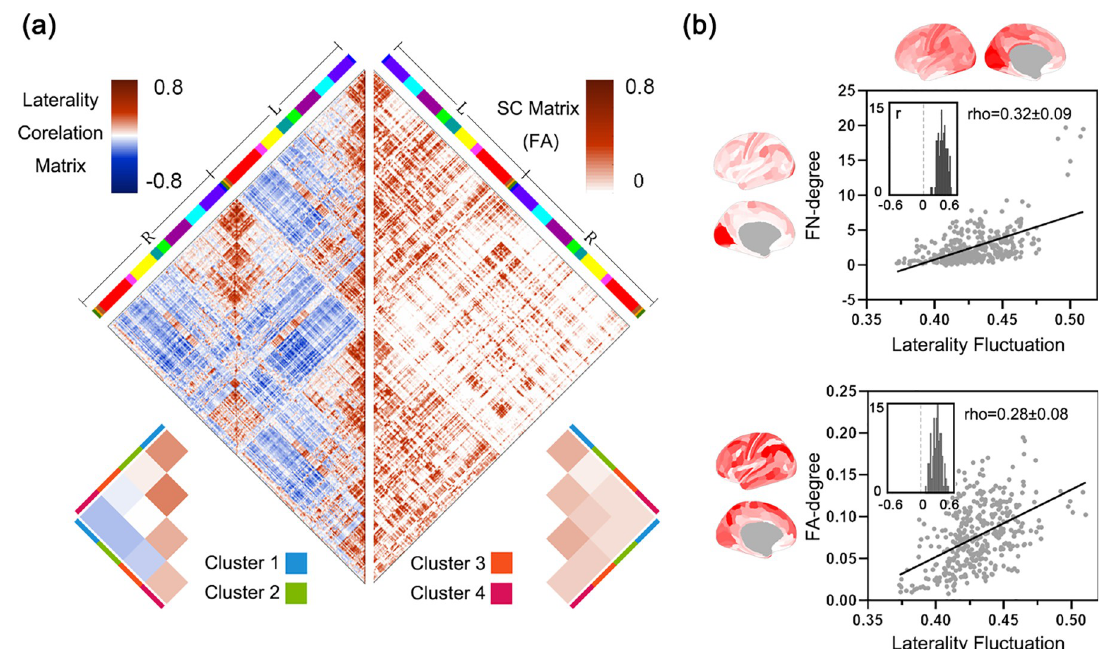
Fig 6. Structural basis of dynamic laterality. (a) Laterality correlation matrix (left half-matrix) and structural connection matrix (right half-matrix) demonstrates high level of correlation. These 2 matrices are obtained by averaging across all 99 participants. L, left hemisphere; R, right hemisphere. The color ribbons indicate the network arrangement of CAB-NP detailed in Fig 2. (b) Upper: the relationship between a structural measure (FN-degree) and the LF across all brain regions. Lower: the relationship between another structural measure (FA-degree) and the LF. The large scatter maps show the association between the averaged map of dynamic laterality measures and the averaged FA-/FN-degree map (both across all 99 participants), and the inset shows the distribution of the individual correlation coefficients between the FA-/FN-degree map and laterality fluctuation map of each participant. The underlying data for this figure can be found in S4 Data. CAB-NP, Cole-Anticevic Brain-wide Network Partition; FA, fractional anisotropy; FN, fiber number; LF, laterality